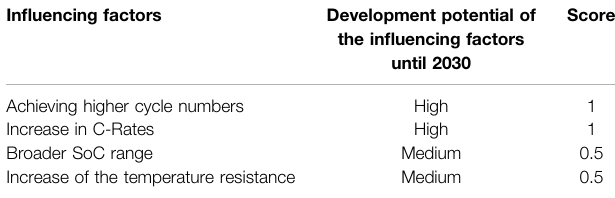
Table 3 | NMC Chemistry market share (%) according to literature, experts and